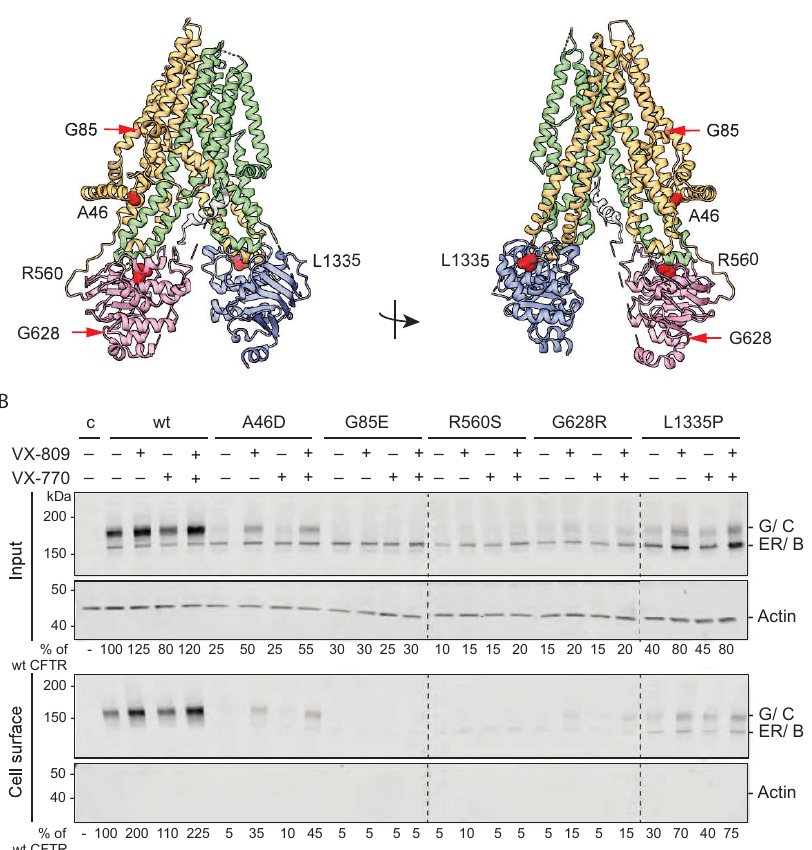
Figure 1. VX-809 improves total CFTR and cell-surface levels of hypo-responding CF-causing mutants. ( A ) Cartoon of CFTR cryo-EM structure (PDB: 5UAK) and location of CF-causing mutations in color- coded CFTR domains (TMD1 in orange, NBD1 in pink, R-region in grey, TMD2 in green, and NBD2 in blue). ( B ) HEK293T cells expressing wild-type CFTR or indicated CFTR mutants were pre-incubated for 18 h with 3 µ M VX-809 and/or for 15 min with 3 µ M VX-770. Cells then were incubated with 0.5 mg/mL Sulpho-NHS-SS-biotin for 30 min at 4 ◦ C. Unbound biotin was removed by the addition of 1% BSA. Cells were lysed with 1% Triton X-100 and lysates were either subjected to pull-down with Neutravidin beads (cell surface) or used directly for SDS-PA gel analysis (input) on 7.5% SDS-PA gels. CFTR and actin were visualized by Western blotting. Representative blots of three repeats. ER, ER form (also called B band); G, complex-glycosylated CFTR form, which has left the ER and may reside in or beyond the Golgi complex (also called C band); c (control), transfection with empty vector; wt, wild-type CFTR. Quantifications are below each lane and used for plots